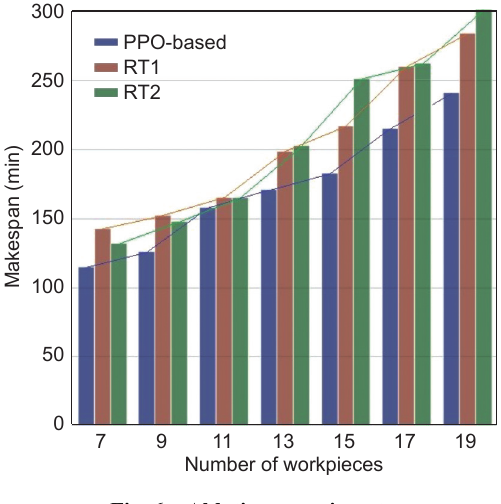
Fig. 6 Ablation experiment.